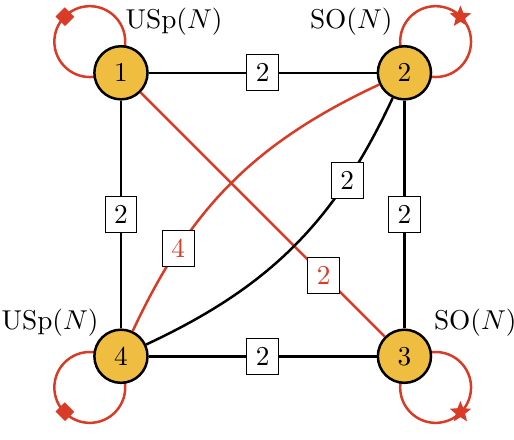
Figure 15 . Quiver diagram for the Spin(7) orientifold of phase A of Q 1 , 1 , 1 using the involution in eqs. (5.3), (5.4) and (5.5), together with our choice of γ